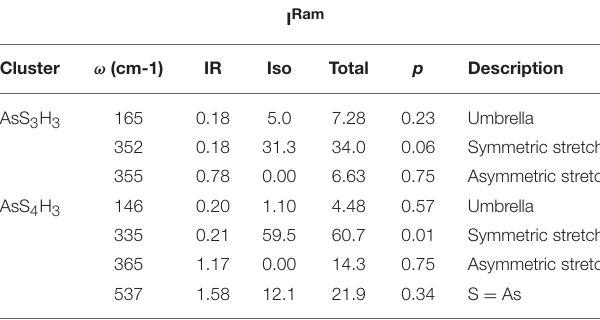
TABLE 1 | Raman and IR vibrational modes of As-S